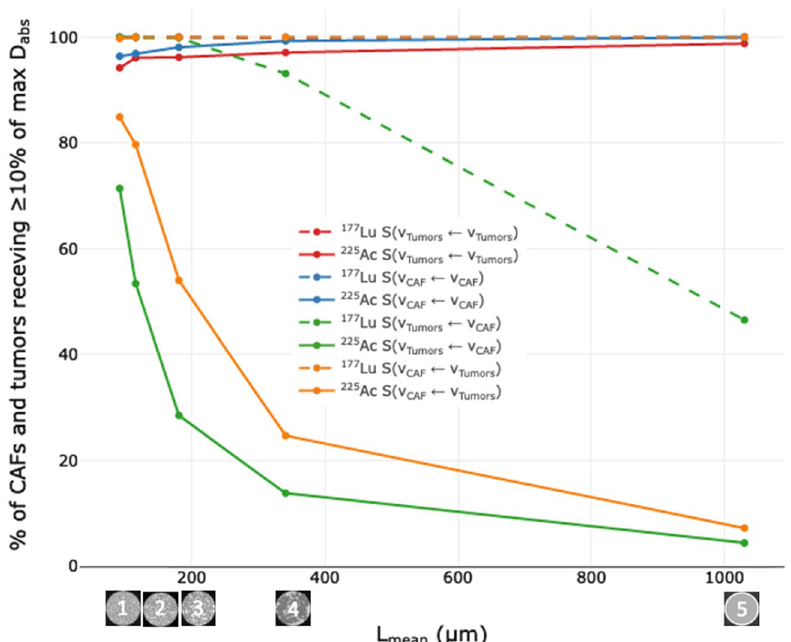
Fig. 5 Percentage of CAFs and tumors receiving 10% of the maximum D abs within the SM across the ≥ five models using either tumor cells or CAFs as sources or targets for 177 Lu and 225 Ac. Values for 177 Lu S(v Tumors v Tumors ), S(V CAF V CAF ) and S(V CAF V Tumors ) are ← ← ←